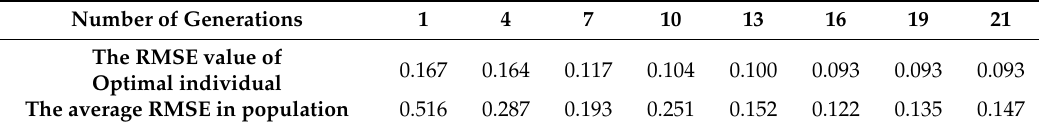
Table 6. The RMSE value of the optimal individual and the average in the population.